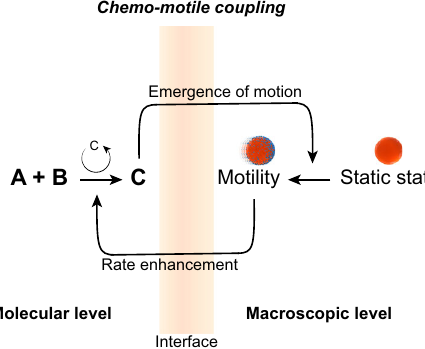
Fig. 6 Reciprocal coupling between motility and chemistry across length scales. Self-reproducing lipids initiate and accelerate the movement of oil droplets and, reciprocally, the chemotactic movement of the droplets increases the rate of